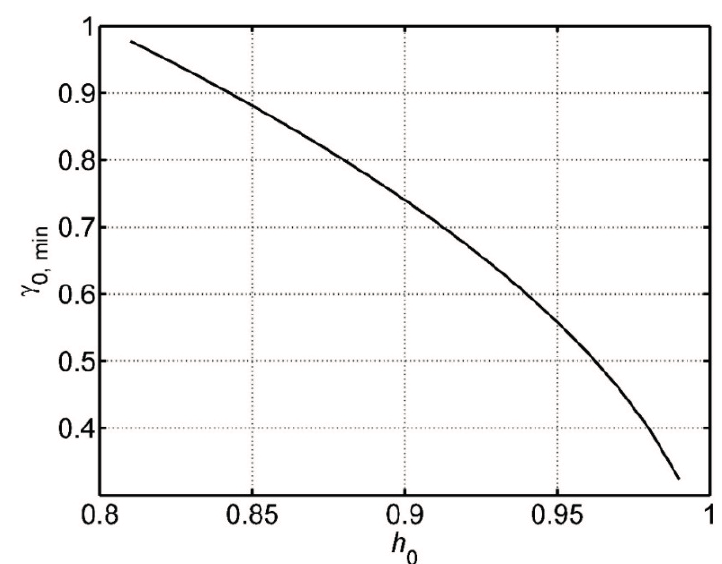
Figure 12. The lowest value γ 0,min for which a given hit success rate h 0 can be achieved, when the actuator spacing is less than the target